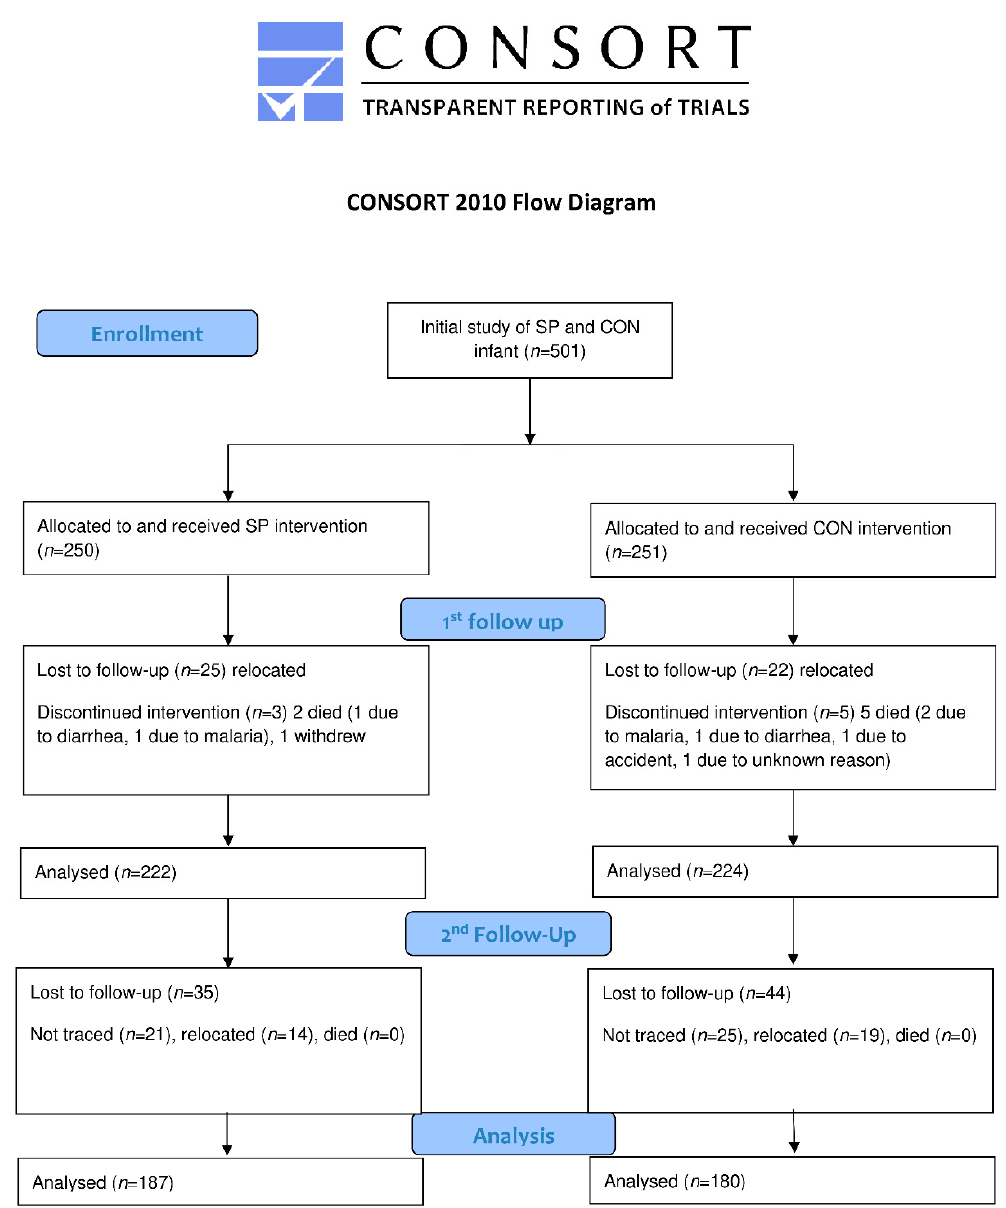
Figure 1. Flow chart of study participants. SP, maize-soya based control porridge plus the multiple micronutrient spirulina; CON, maize-soya based control porridge